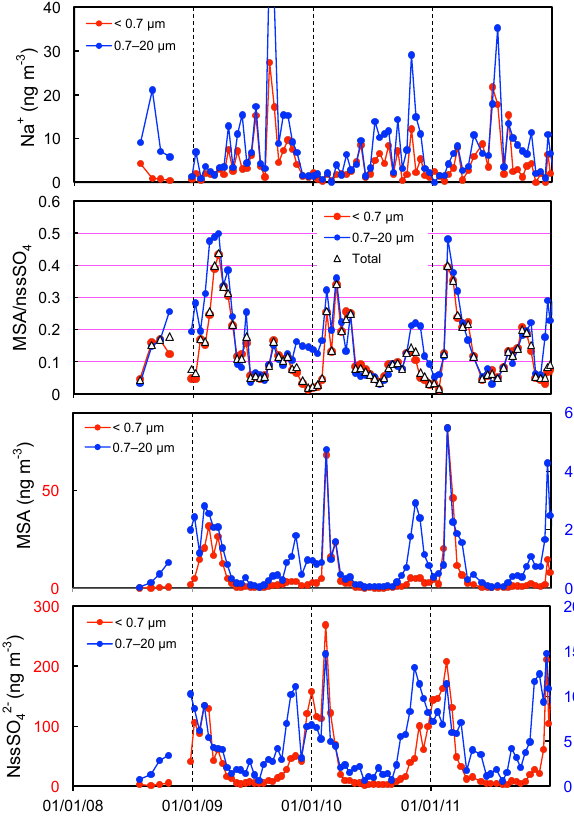
Figure 6. Year-round records of the chemical composition of aerosol collected from 2008 to 2011 at Concordia on the 12-stage impactor, distinguishing between small (the last six stages, i.e., 0.08–0.7µm diameter) and large (the first six stages, i.e., 0.7–20µm diameter) particles. From top to bottom: sodium, MSA / nssSO 4 ra- tio, MSA, and nssSO 4 . For the MSA / nssSO 4 ratio, we also report values corresponding to the total mass of collected aerosol (open triangles). Note the different scales used for small (left scales) and large (right scales) particles for MSA and nssSO 4